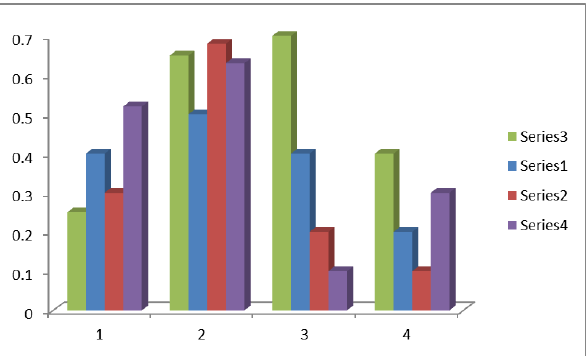
Figure 5. Graph of progress of patient ∂ 3 .